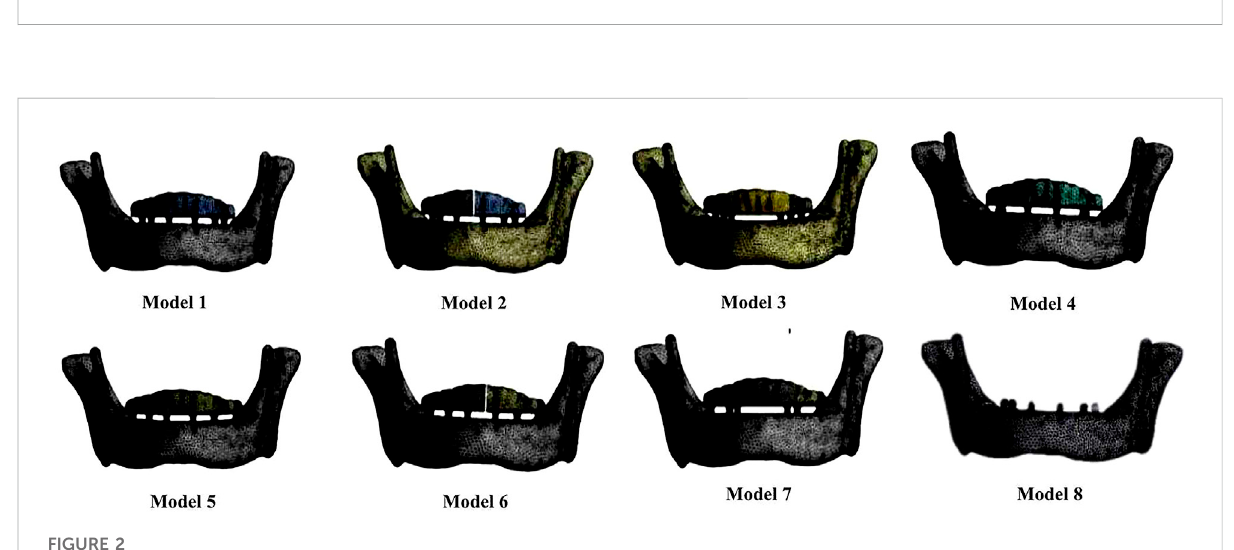
FIGURE 1 Three-dimensional fi nite element model. (A) Mandibular model; the ratio between cancellous and cortical bone thickness was approximately 10:1. (B) From left to right, one-piece, two-piece, and three-piece frameworks, respectively. (C) Implant system assembly.